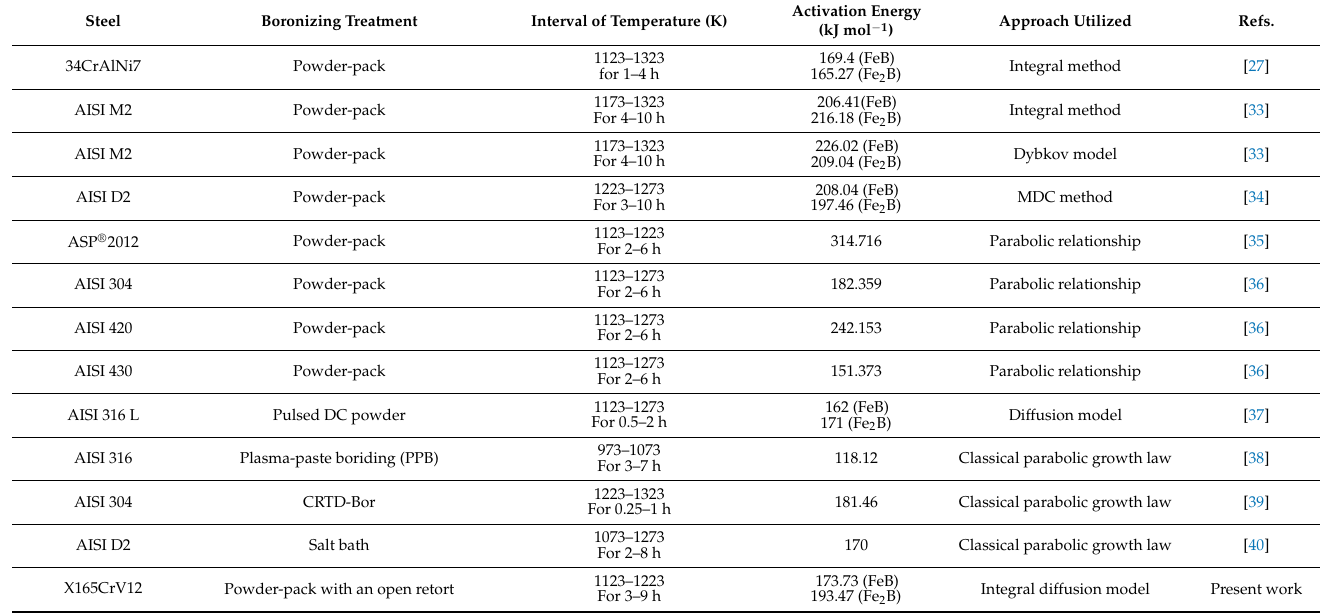
Figure 13. Plots of Arrhenius laws for boron diffusion coefficients in the two borides: ( a ) FeB ( b ) Fe 2 B. Table 5. Comparison of reported activation energies with the present